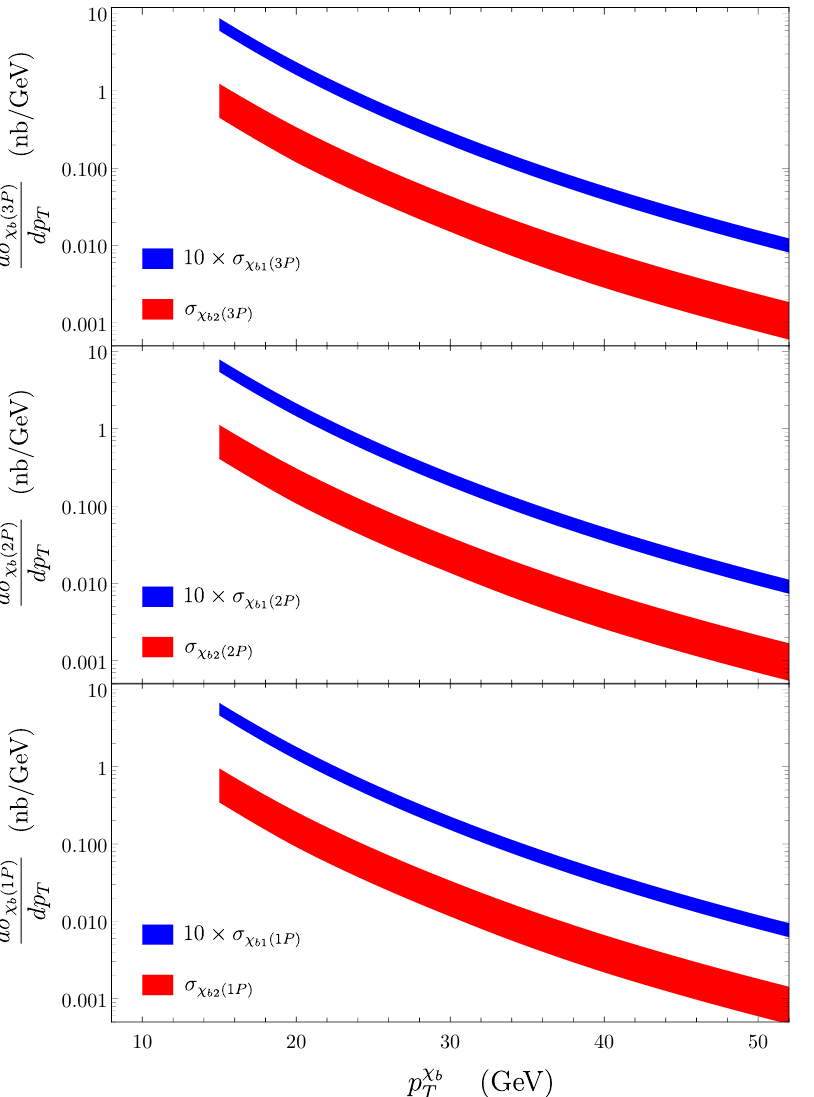
Figure 7 . Differential production cross sections of the χ b 1 ( nP ) and χ b 2 ( nP ) ( n = 1 , 2, and 3) at √ the LHC center of mass energy s = 7 TeV and in the rapidity range 2 < y < 4 . 5 . The χ b 1 ( nP ) cross sections have been multiplied by 10 to distinguish them from the χ b 2 ( nP ) cross sections on the logarithmic